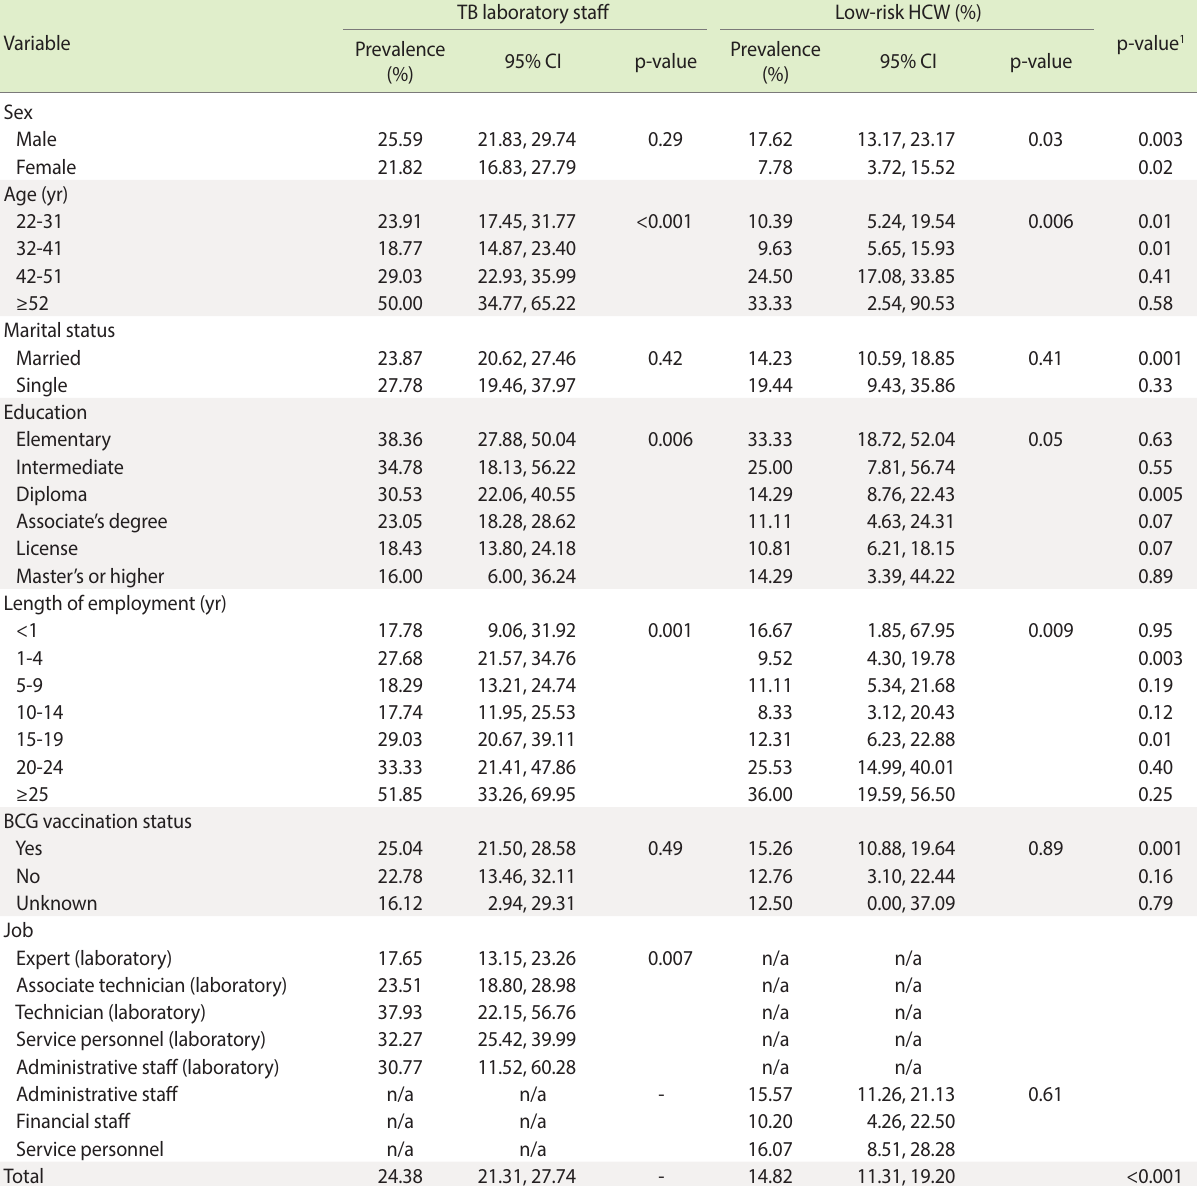
Table 3. Prevalence of LTBIs in TB laboratory staff and low-risk HCWs based on TST results